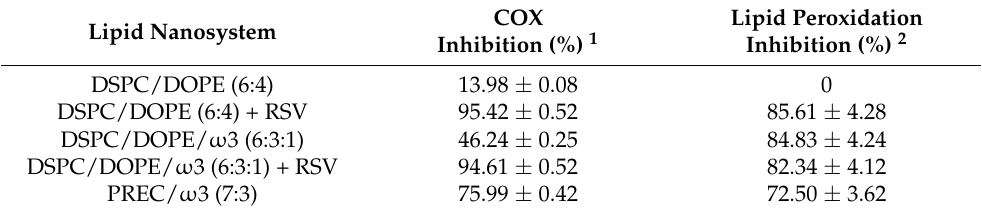
Table 1. Inhibitory effects of Cox and lipid peroxidation of the lipid nanosystems. The data represent the means ±